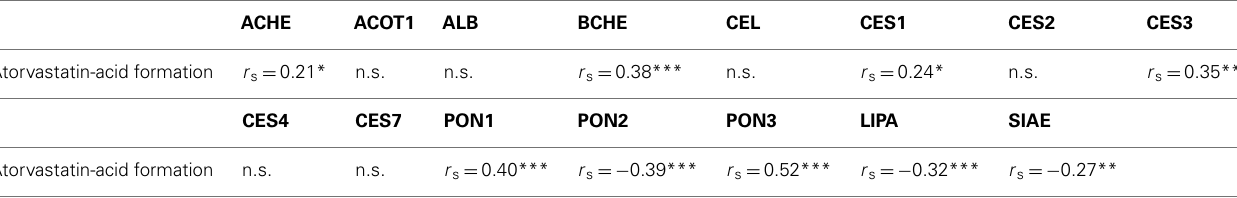
Table 1 | Correlation analysis of candidate gene expression and atorvastatin-lactone